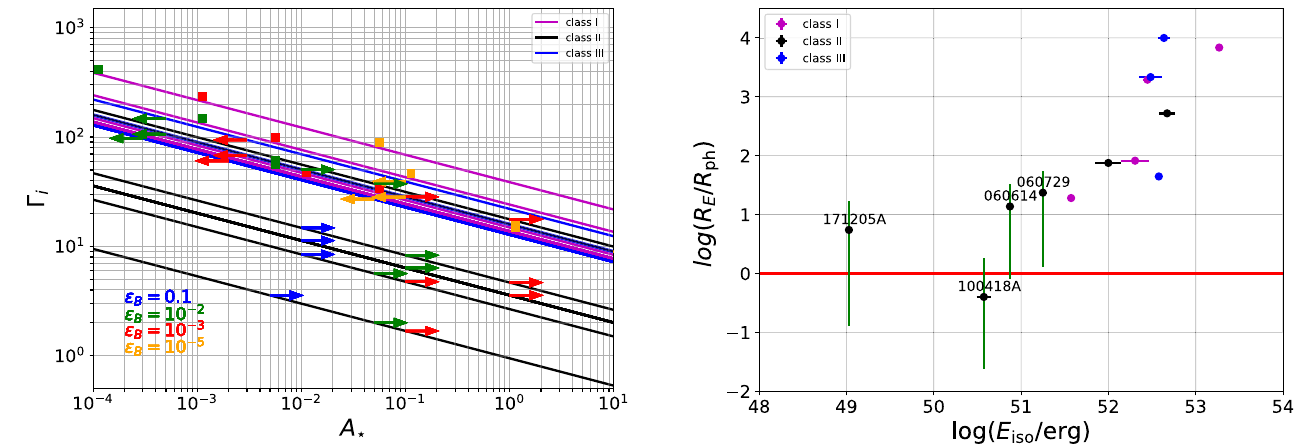
Fig. 4 | Ratio of the prompt emission radius, R E and the photospheric radius, E R ph versus total isotropic energy iso . Purple, black and blue points represent GRBs in the three different classes I, II, III respectively (see Supplementary Tables1 – 3).Theerrorscorrespondtoasigni fi canceofonesigma.Thelowluminous GRBswithlowestLorentzfactor(GRBs060614,060729,100418Aand171205A)are markedbytheirnames.FortheseGRBsweconsider ϵ B =0.1,leadingtotypicalinitial jet Lorentz factor Γ i ≈ 10 and ratio R E / R ph ~5 − 25, but for GRB 100418A, which is marginally consistent with R E / R ph ~1. For all other GRBs, we assume ϵ B =10 − 3